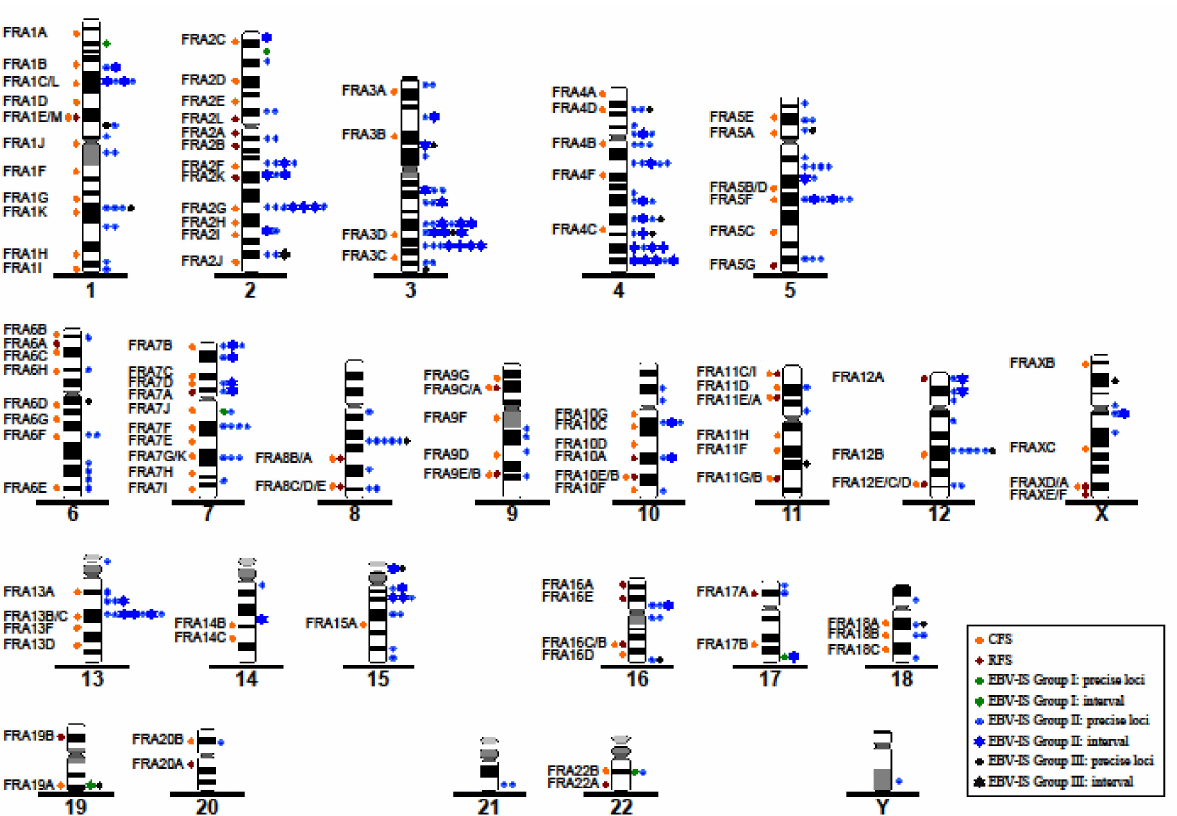
Figure 2. The distribution of EBV-IS and CFS/RFS at the chromosomal level. Common and rare fragile sites (CFS and RFS, respectively) are depicted at chromosomal cytobands on the left side of the chromosome ideograms, and on the right side, EBV-IS observed in our study are illustrated. The green dots represent EBV-IS of group 1 BL cell lines, blue of group 2, and black of group 3. In case of conflict, when the integration site was spanning several cytobands the integration site was assigned to the most probable band based on the integration observed in other BL cell lines. Conflict cases are indicated as a star and their colour reflects the equivalent BL-CL group as indicated